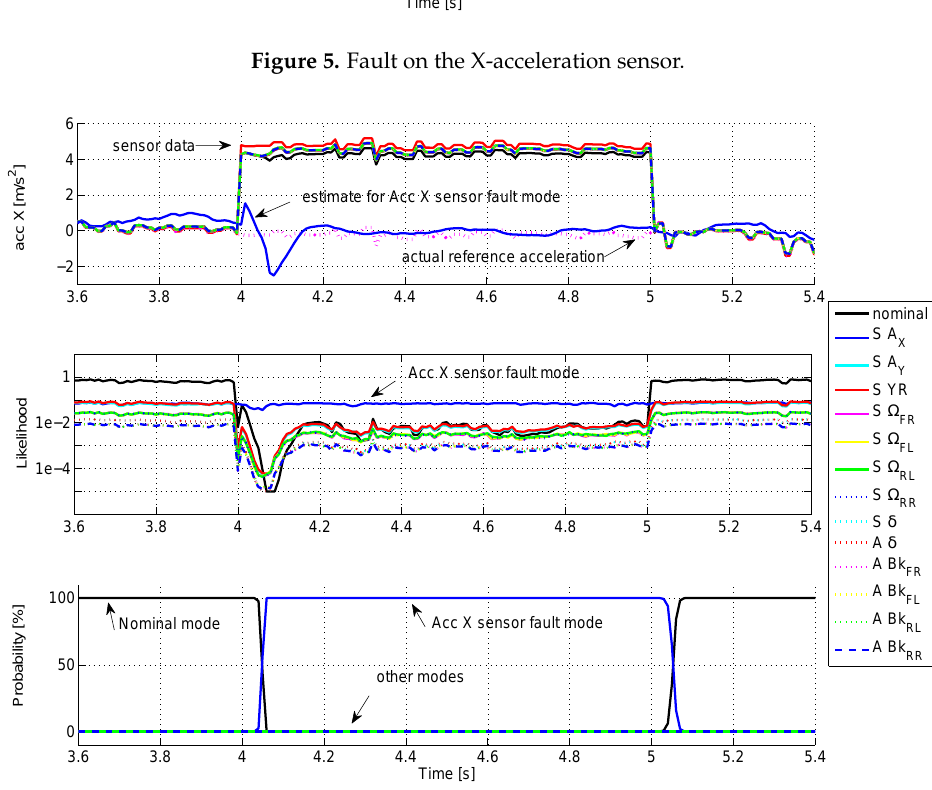
Figure 6. Fault on the X-acceleration sensor